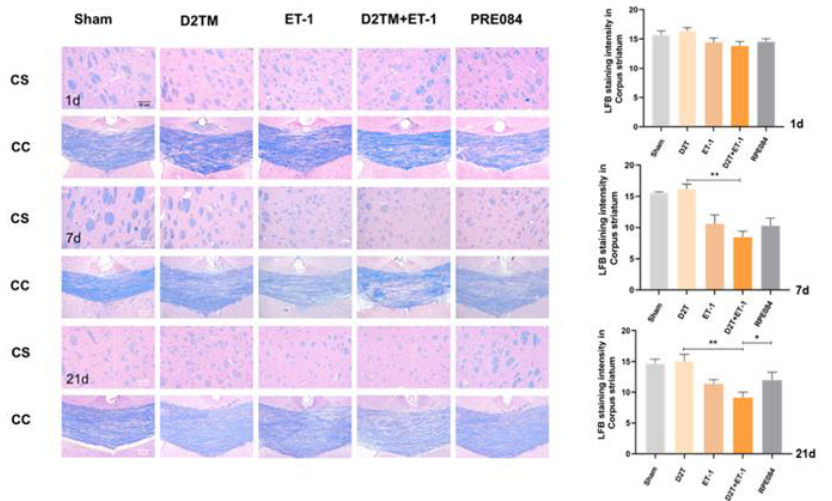
Figure 3. PRE084 prevented levels of brain demyelination and white-matter damage in mice with diabetes and stroke. Representative images of Luxol-fast-blue staining (LFB) in the peri-infarct corpus striatum (CS) and the corpus callosum (CC) 1, 7, and 21 d after ET-1 injection. Quantitative analysis of myelin density was expressed as the percentage of the immunostaining intensity in the CS. Data are expressed as mean ± SEM; n = 4 –5/group. Scale bars = 50 μm. * p < 0.05, ** p < 0.01.